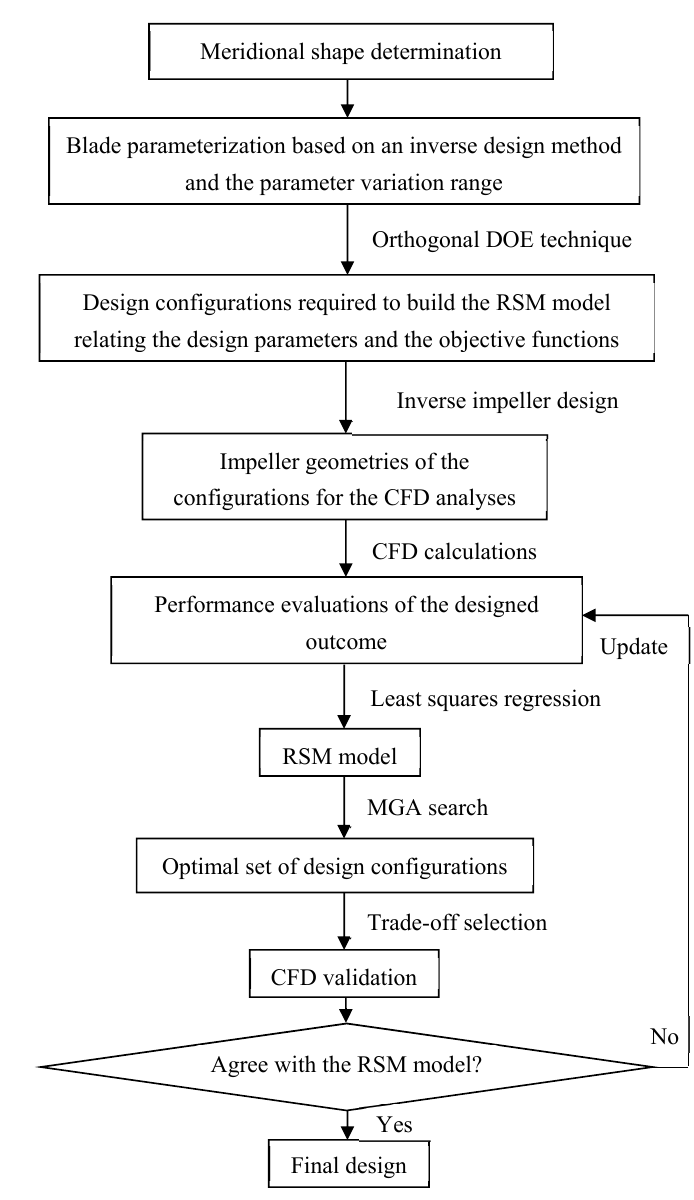
Figure 13. A typical multi-objective optimization process based on the inverse design method [56].